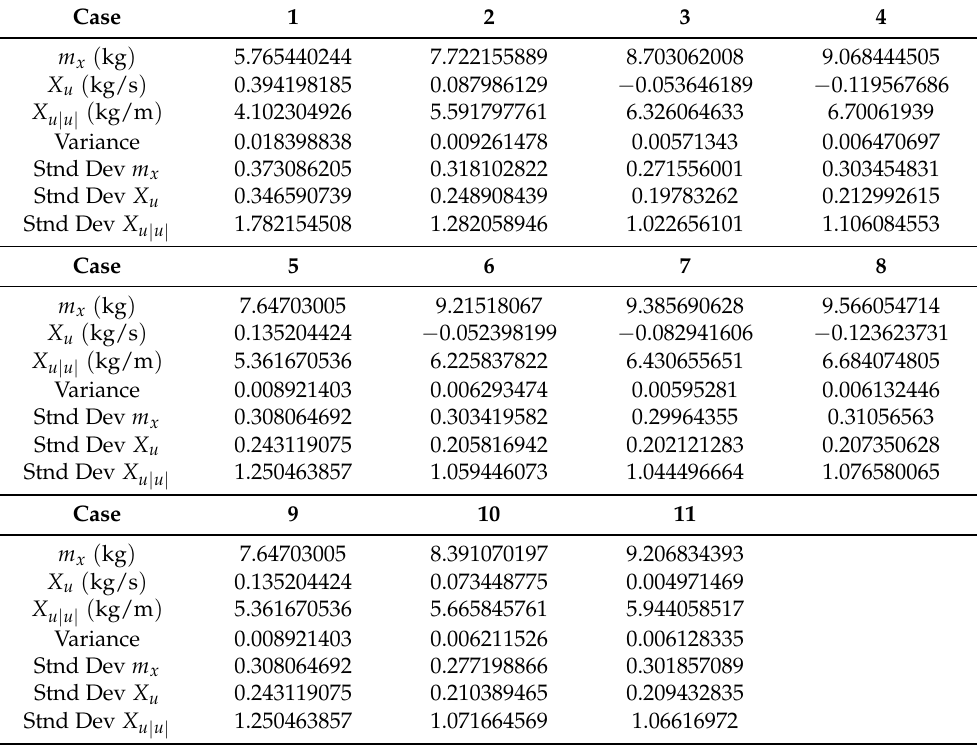
Table A1. Estimation of hydrodynamic parameters for the positive motion in b x with 120 iterations.